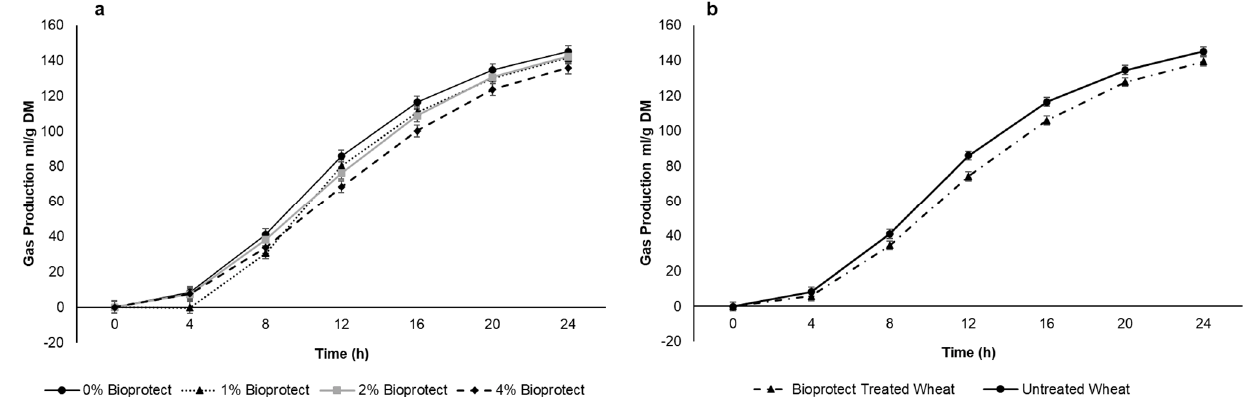
Figure 2. Effect of ( a ) Bioprotect treatment in general ( b ) effect of different dosages of Bioprotect on the cumulative gas production. Gas production curves are representative of 24 h incubation at 39 ◦ C in buffered rumen fluid. The standard error of the difference for the interaction between period and dietary treatments and time is displayed on the on the graph.